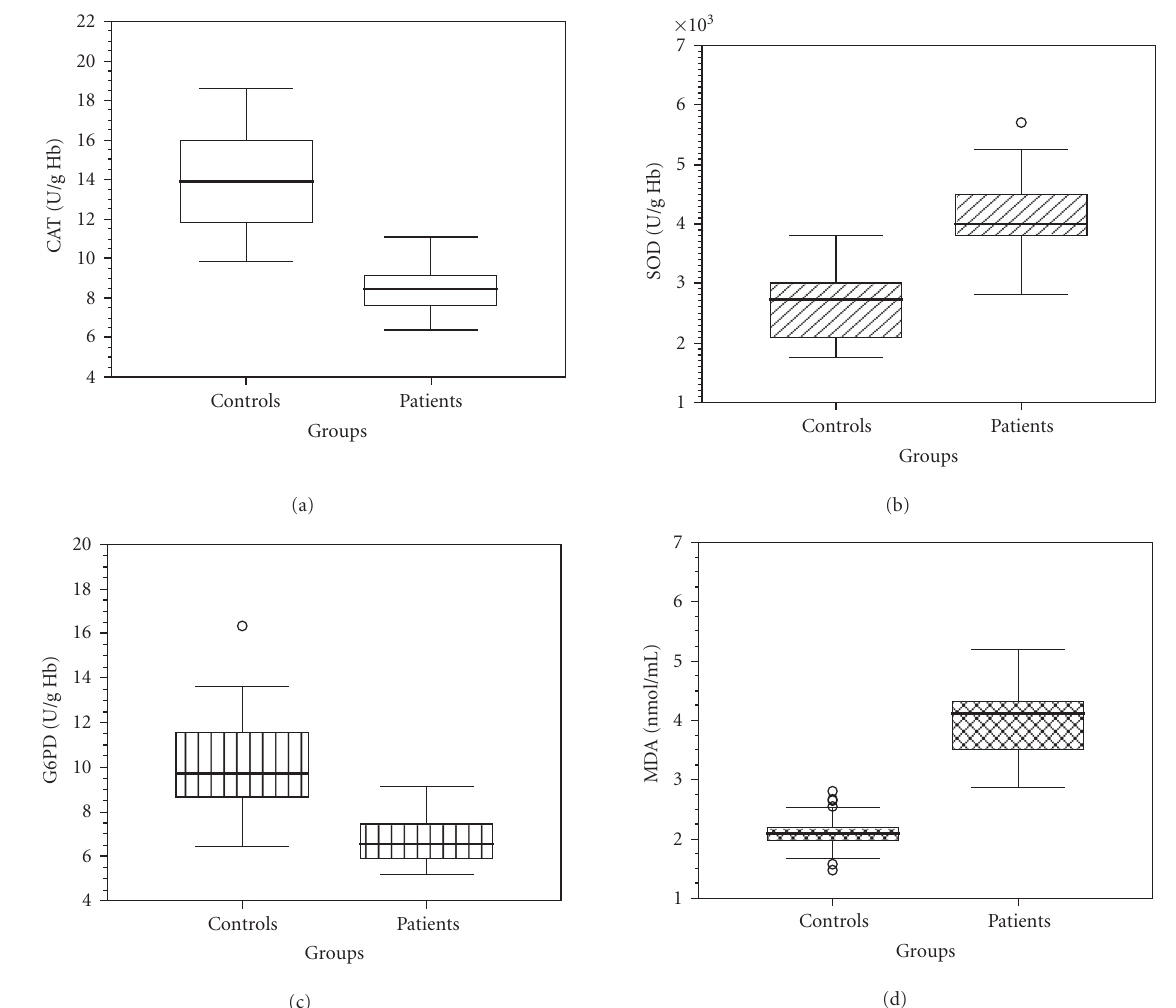
Figure 1. (a) CAT, (b) SOD, (c) G6PD, and (d) MDA serum levels of acne patients and controls in box plot graphics ( ◦ : Outliers). Table 1. Correlation among disease severities and serum levels of antioxidant enzymes and MDA evaluated by the Spearman rank correlation. Severity and enzymes Statistical values